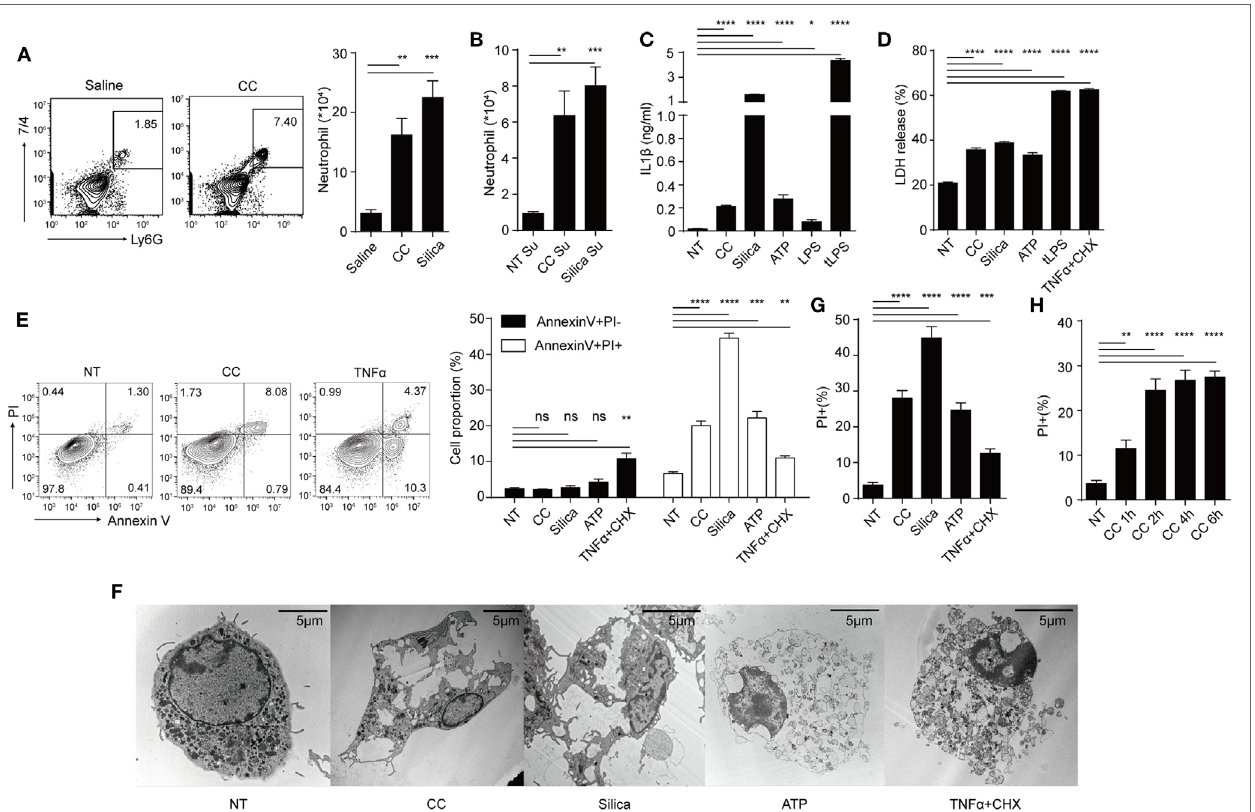
FigUre 1 | Cholesterol crystals (CC) induce both NLRP3 inflammasome activation and a rapid necrotic cell death in the phagocytic cells. (a) C57BL/6 mice were i.p. injected with 500 µg of Silica or CC in 1 ml saline and rested for 16 h. Intraperitoneal cells were harvested and stained with Ly6G-APC and 7/4-FITC. The right panel is the bar graph of FACS plots on the left. n = 4 ( n indicates the number of repeats of each group), N = 3 ( N indicates the number of biological repeats of the experiment). Two-tailed Student’s t analysis results for all figures are indicated as follows: p < 0.001: ***; p < 0.01: **; p < 0.05: *; p at 0.05 or larger was considered non-significant: ns. (B) Supernatants of treated BMDM (CC: 1 mg/ml, Silica:500 μ g/ml for 8 h) in 12-well plates (about 4 × 10 5 cells) were collected and injected i.p. 16 h later intraperitoneal cells were harvested and stained as in (a) . n = 4. N = 3. (c) BMDM were primed with Pam3csk4 (100 ng/ml) for 12 h and then treated with indicated stimulus for 12 h (CC:500 μ g/ml, Silica: 100 µg/ml, ATP:5 mM, LPS: 2 µg/ml, tLPS: LPS was packed into liposome with final concentration 2 µg/ml as described in the Section Materials and Methods). IL-1 β concentration was determined by ELISA. n = 6. N = 3. (D) BMDM were primed then treated as in (c) for 12 h and the cell death was determined by LDH assay. TNF α + CHX:100 ng/ml TNF α plus 50 µg/ml Cycloheximide. n = 4. N = 3. (e) BMDM were primed then treated as in (D) except treatment duration (CC: 2 h, Silica: 1 h, ATP: 2 h, TNF α + CHX: 6 h) then were collected and stained with Annexin V-FITC and PI. The right panel is the bar graphs of FACS plots on the left. n = 4. N = 4. (F) TEM picture of BMDM primed then treated as in (e) . (g) BMDM were primed then treated as in (e) except stained with PI. This is to indicate that using PI + staining alone faithfully recaptures nearly cell death events as in (e) . n = 6. N = 3. (h) BMDM were primed then treated with CC (500 µg/ml) for different durations then stained with PI. PI + percentages are shown. n = 6. N =